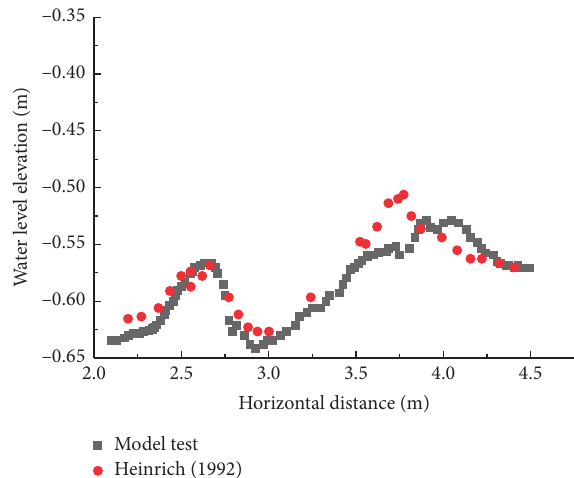
Figure 5: Comparison between the model test results and the calculations of Heinrich for t � 1.5